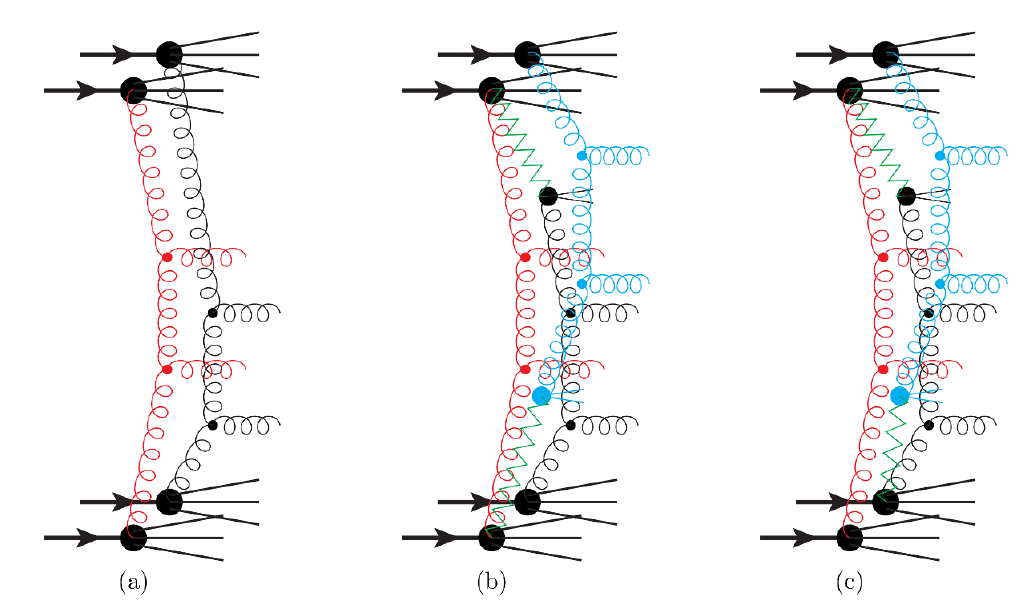
Figure 4 . A schematic picture (cf. (cid:12)gure 3) of multiple scatterings between two projectile and two target nucleons in an AA collision. In (a) there are two separate NN collisions, while in (b) and (c) there is one primary sub-collision and two secondary